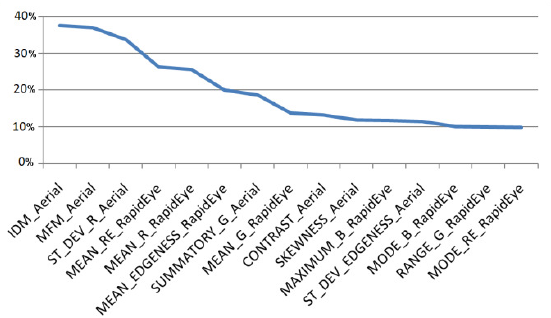
Figure 7: Relevance of features in classification of the aerial image combined with the RapidEye